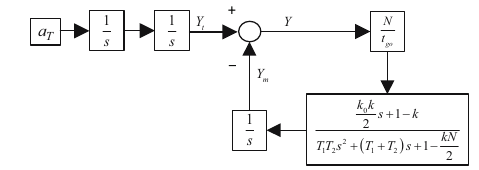
Figure 6: Equivalent model of second - order linearized AACG gui - dance system.